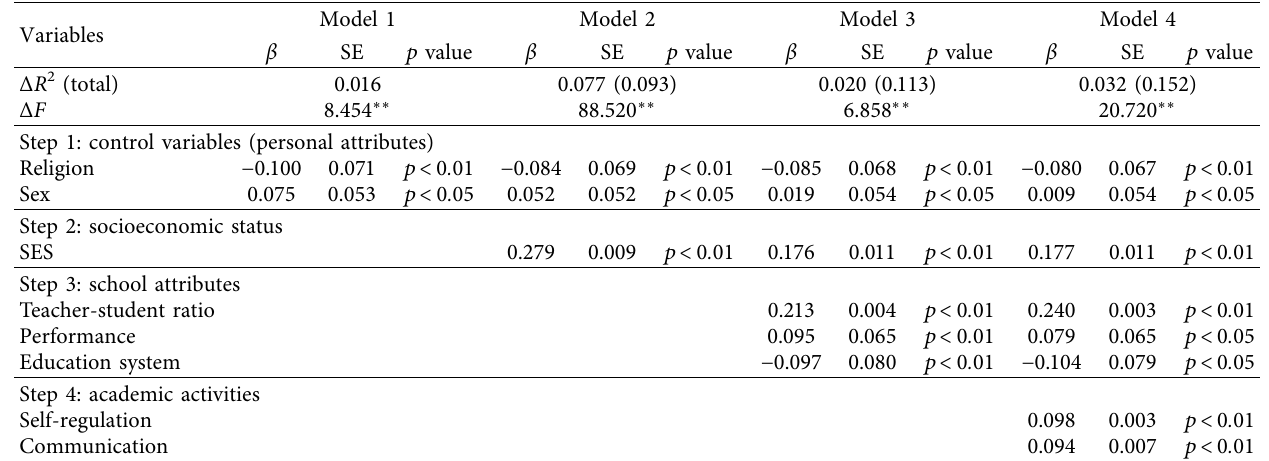
Table 2: Hierarchical multiple regression predicting academic